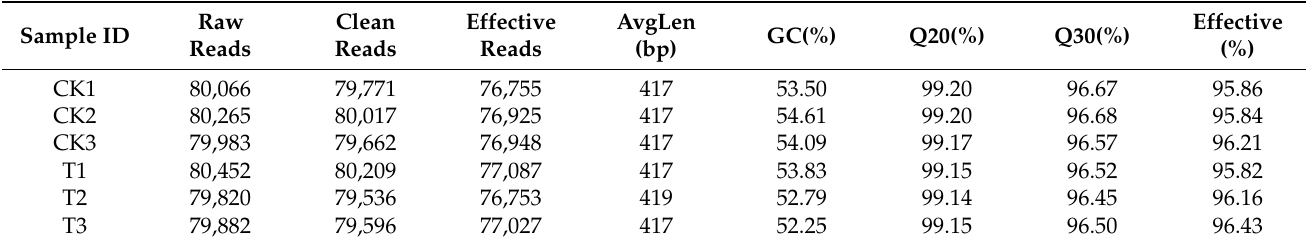
Table 2. Statistical results of the sequencing data of Grapholita molesta gut microbiota before and after ciprofloxacin feeding.